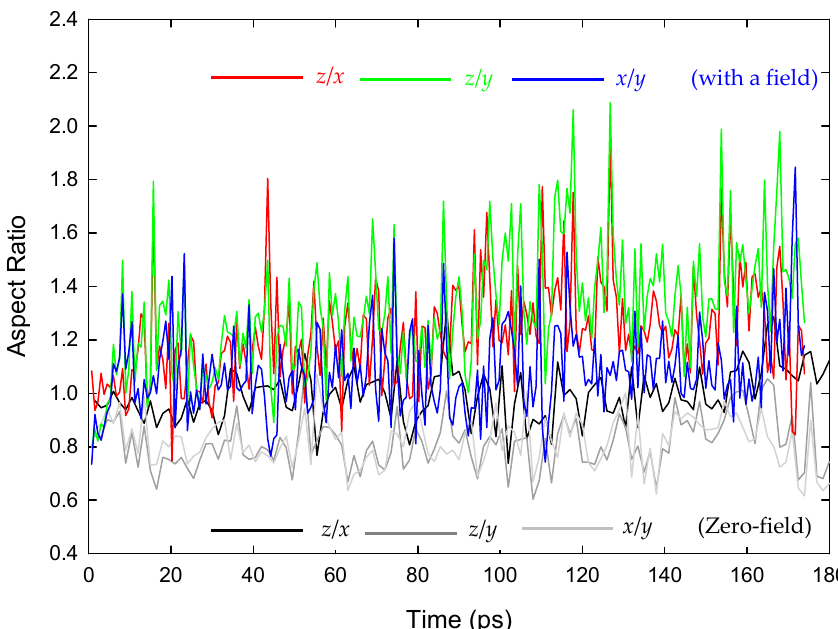
Figure 2. Methane-hydrate-crystallite aspect ratios as a function of time, in the case of initially 12.5 Å-radius spheres surrounded by an aqueous phase, similar in detail and set-up to [30]. Crystallisation simulations were carried out in a similar way to [30] under both zero-field conditions (in black and grey) and in a 250 GHz/0.15 V/Å r.m.s. e//m field applied along the laboratory z -axis. The development of relative elongation along the laboratory z -axis (the direction of e/m-field application) vis- à -vis the x - and y -directions, is